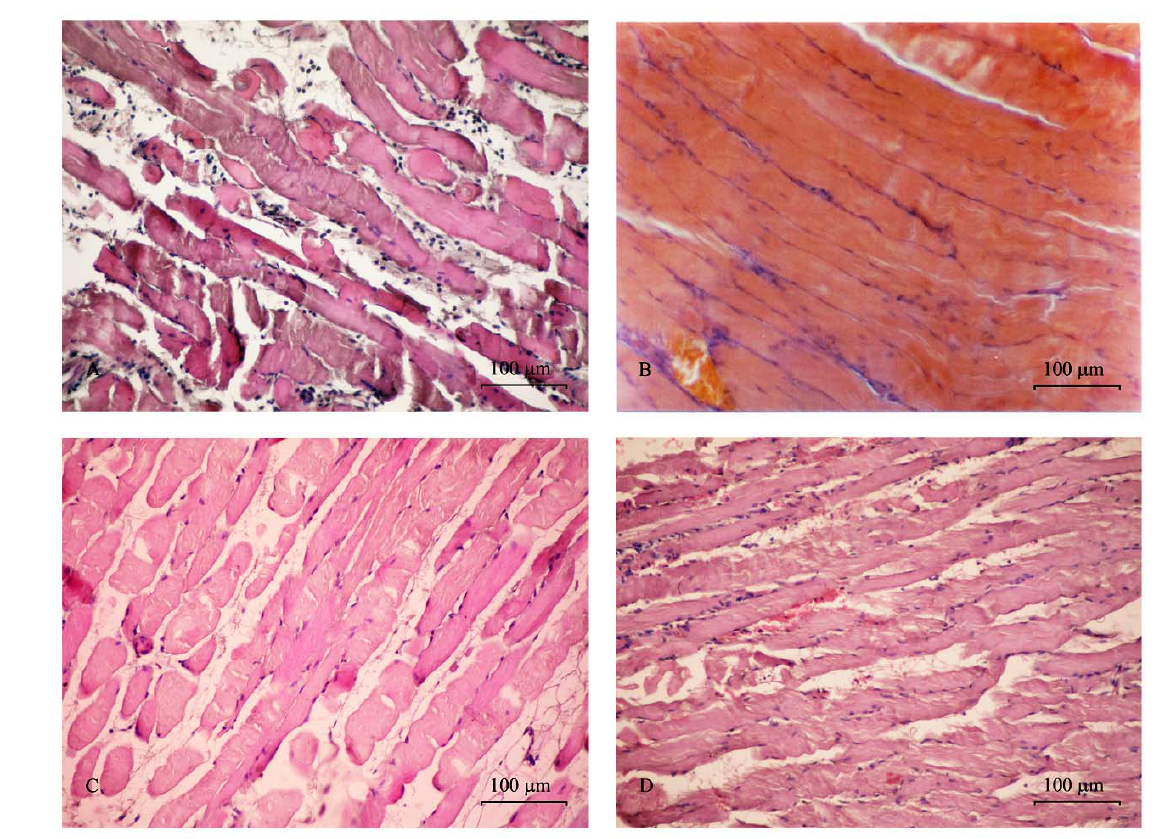
Figure 5. Histological studies on neutralization of myotoxic activity. Longitudinal section of mouse gastrocnemius muscle. ( A ) C.d.t. venom; ( B ) C.d.t. venom pre- incubated with IgG anti- C .PLA ; ( C ) B.j. venom; ( D ) B.j. venom pre-incubated with 2 IgG anti- C .PLA . Magnification 2